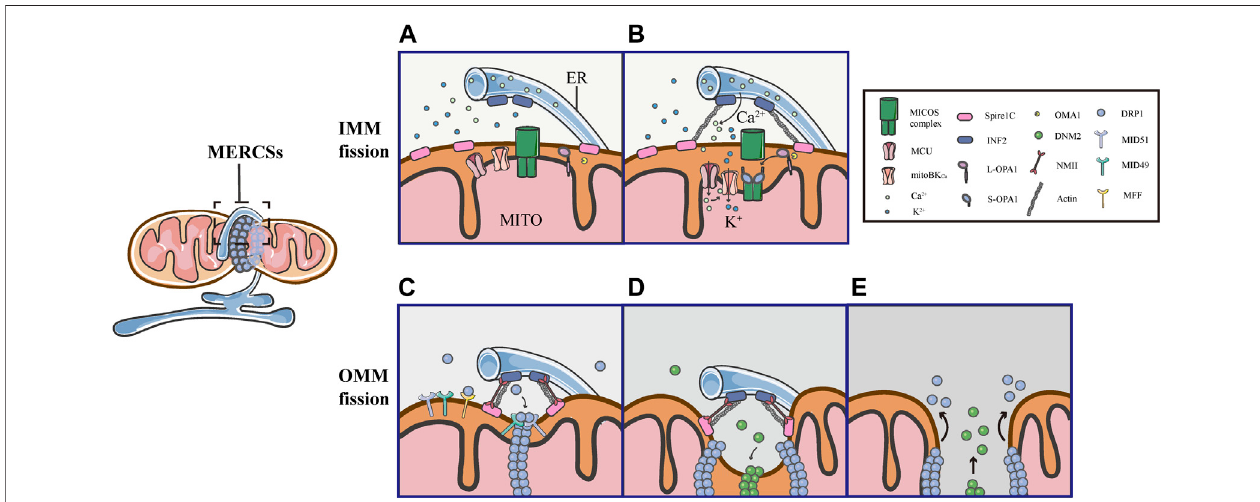
FIGURE 5 | Schematic diagrams of mitochondrial fi ssion at MERCSs. Multiple constriction events of the inner and outer mitochondrial membranes occur at MERCSs. (A,B) The pre-constriction events include INF2-mediated actin polymerization and CoMIC, both of which occur at MERCSs, contributing to the IMM constriction. INF2 and spire1C induce actin polymerization that increases ER-mitochondria interactions, thereby stimulating the ER-to-mitochondrial calcium transfer through the MCU. The subsequent increase in intra-mitochondrial Ca 2+ initiates CoMIC. The elevated mitochondrial Ca 2+ fl ux triggers mitoBK Ca -mediated mitochondrial bulging and depolarization during CoMIC. OPA1 collaboratively regulates CoMIC through proteolytic processing by stabilized OMA1, resulting in the accumulation of S-Opa1, which disrupts the stability of Mic60-mediated OMM – IMM tethering. (C) The actin − NMII-dependent constriction provides the pre-constricted siteattheOMM.NMII fi lamentsarepresentneartheconstrictionsitealongwithactin fi laments,bothofwhichensuretheconstrictionoftheactincable,exertingpressure on mitochondria, bringing about an indentation on the surface of the OMM. DRP1 then assemblies at these pre-constricted sites by binding to its receptors, forming a ringlike structure to further constrict the membrane. (D,E) Finally, DNM2 cooperates with DRP1 to drive complete fi ssion before disassembling of the fi ssion machinery.